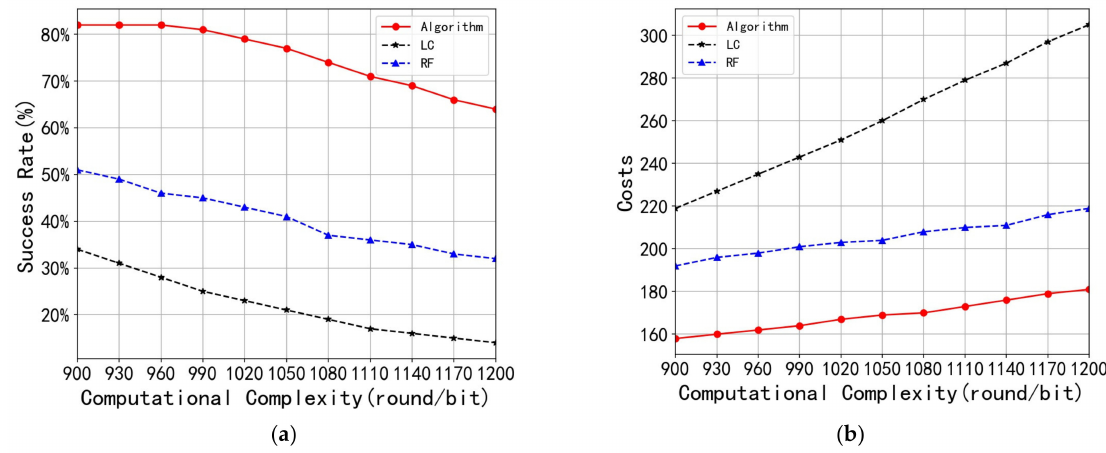
Figure 5. Simulation under diverse computational complexity values. ( a ) Task successful rate under various computational complexity, and ( b ) execution cost under various attenuation